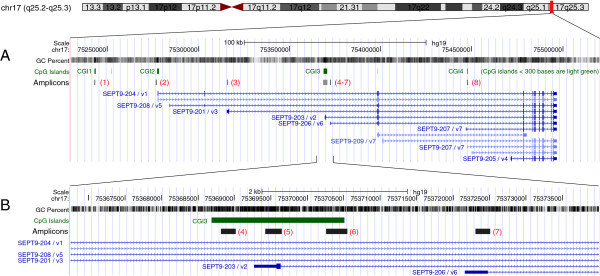
Genomic organization of SEPT9. The UCSC genome browser (http://genome.ucsc.edu) was used to display the location and genomic organization of SEPT9 on chromosome 17q25. (A) Genomic region covering approximately 300 kb: the eight amplicons (IDs given in red letters and within brackets) are shown after aligning their sequences using BLAST; CpG islands are shown in the track above the amplicons and gene transcripts are shown in the tracks below the amplicons. CGIs were numbered for easier reference within this manuscript. The UCSC display of transcripts is annotated with the combined IDs from Ensembl and NCBI/gene map for easier cross platform identification. (B) Detail of approximately 6 kb showing a higher resolution of the locations of the closely neighboring amplicons 4 to 7.